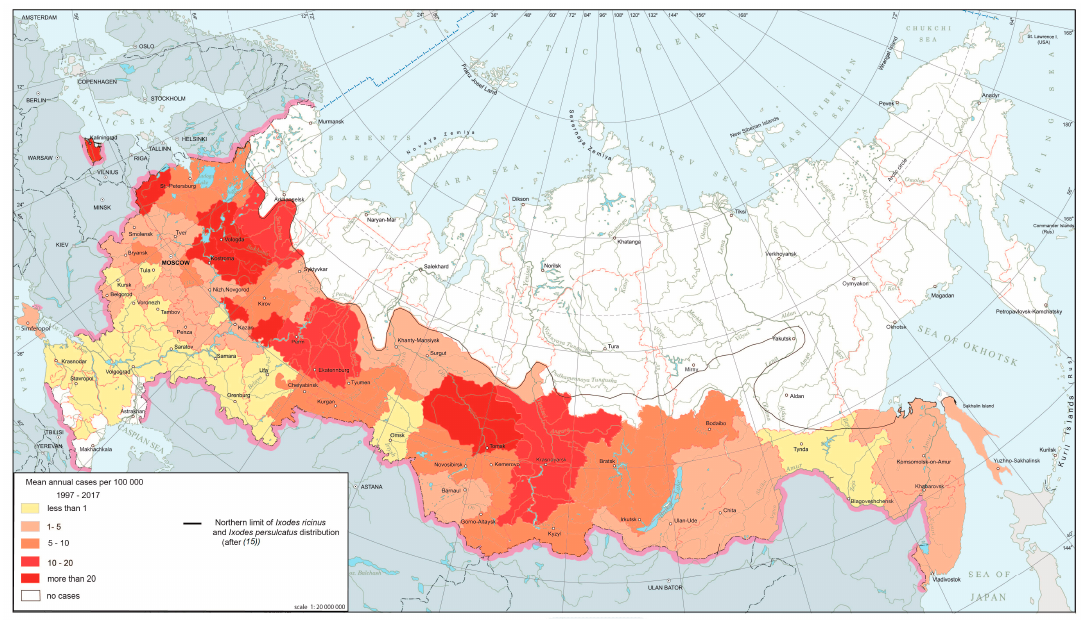
Figure 1. Ixodid tick-borne borrelioses morbidity in Russia, 1997–2017.